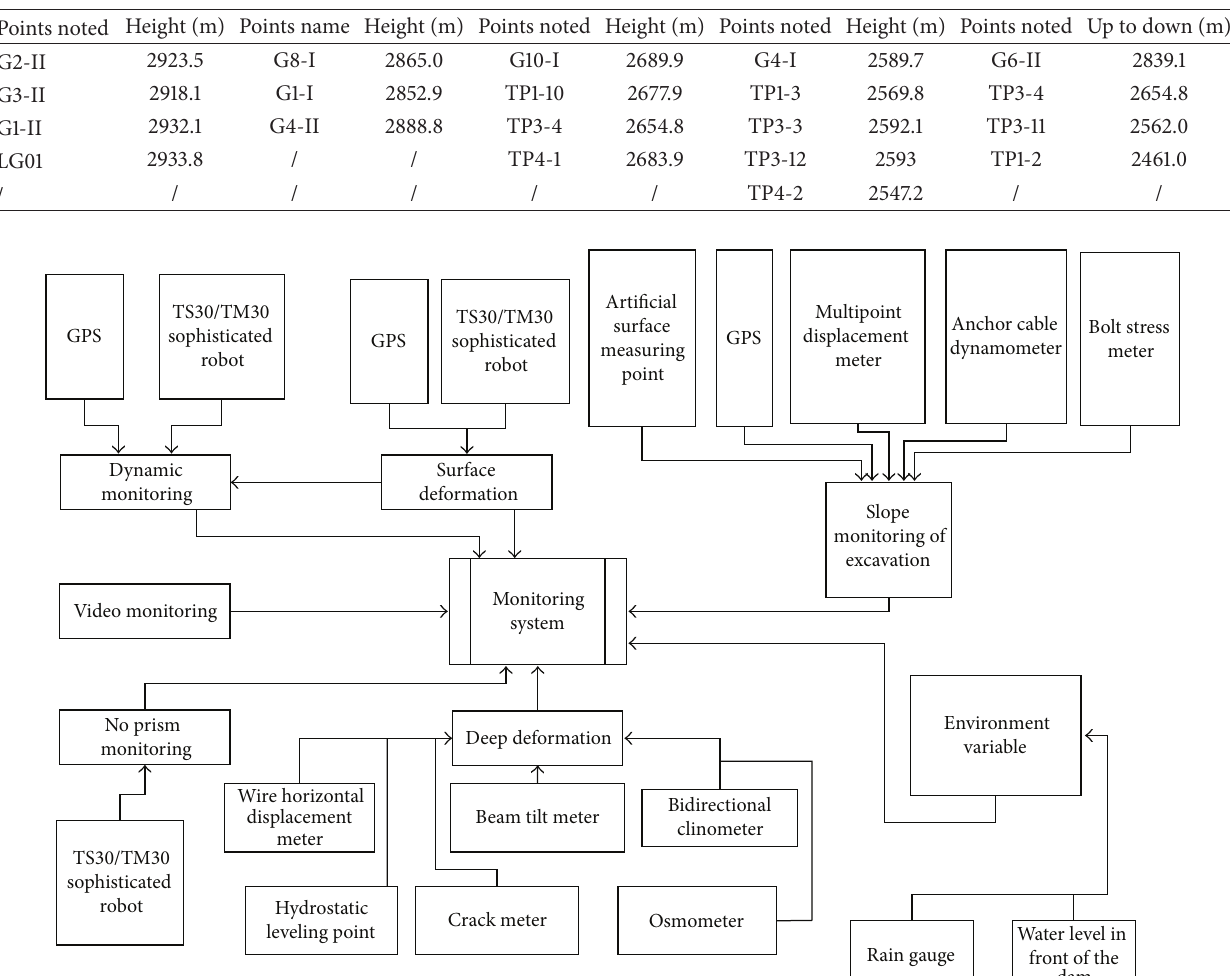
Table 1: Monitored points to different heights from downstream to upstream.